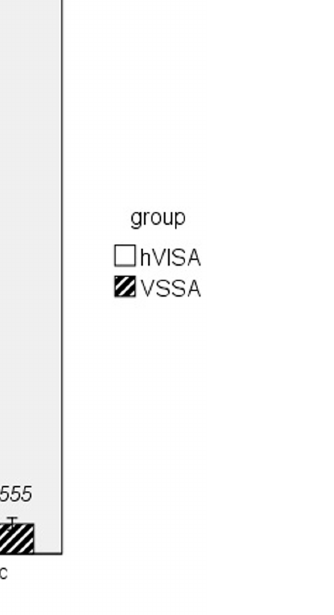
Figure 1. Relative isaA , msrA2 , asp23 , gpmA , and aphC gene expression of hVISA strains (n=24) compared with VSSA (n=30), as determined by quantitative real-time PCR and normalized to 16S rRNA expression. Bar means the mean of relative gene expression. Error bar: 95% CI. The value of relative gene expression was the averages of triplicate samples. p -value as determined by One-Way ANOVA test.